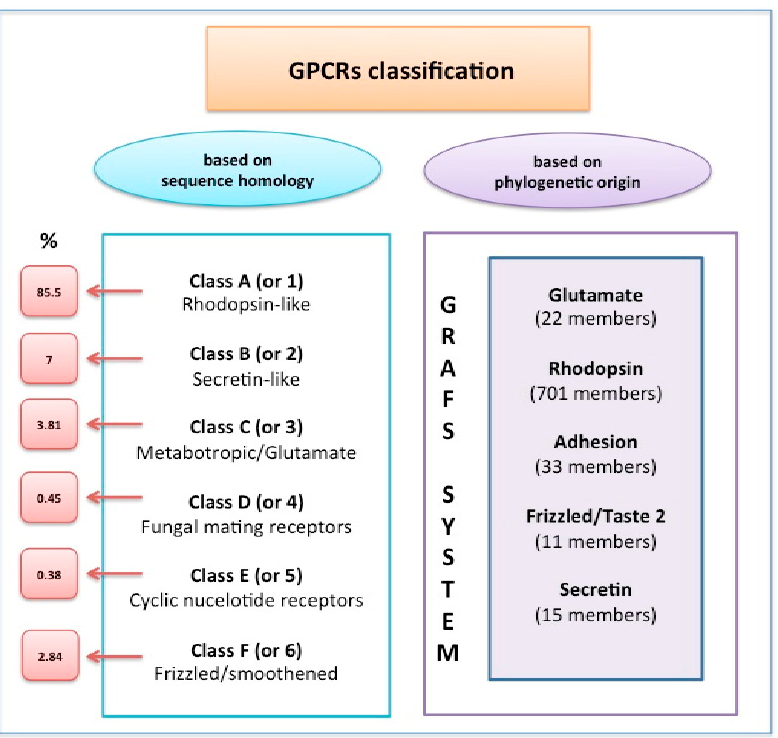
Figure 1. G-protein coupled receptors (GPCRs) classification. The International Union of Pharmacology (IUPHAR) classification (left column) applies to both vertebrates and invertebrates (Class D and E are unique to invertebrates). The GRAPH system (middle column) applies specifically to vertebrates.